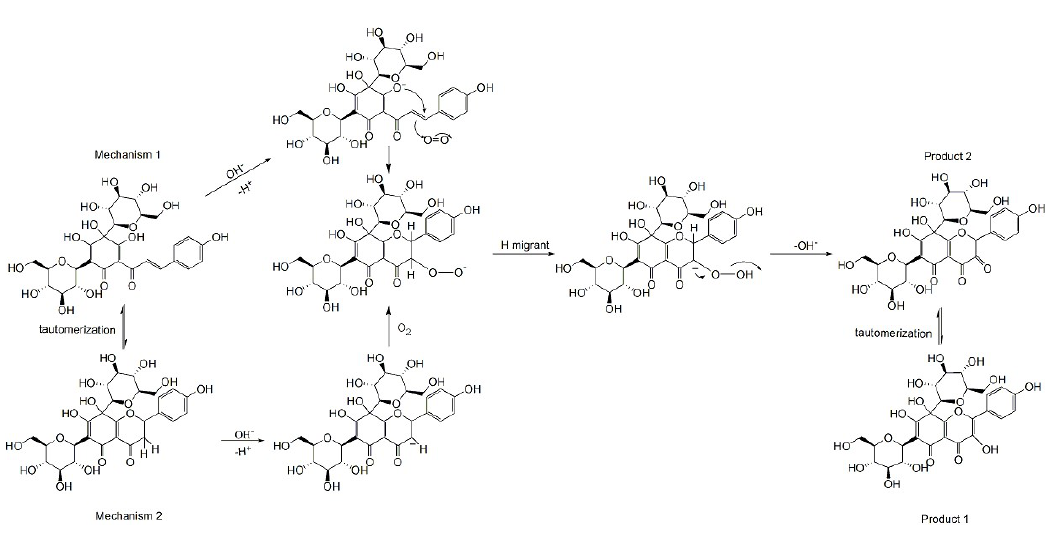
Table 4. Kinetic parameters of HSYA degradation under specified